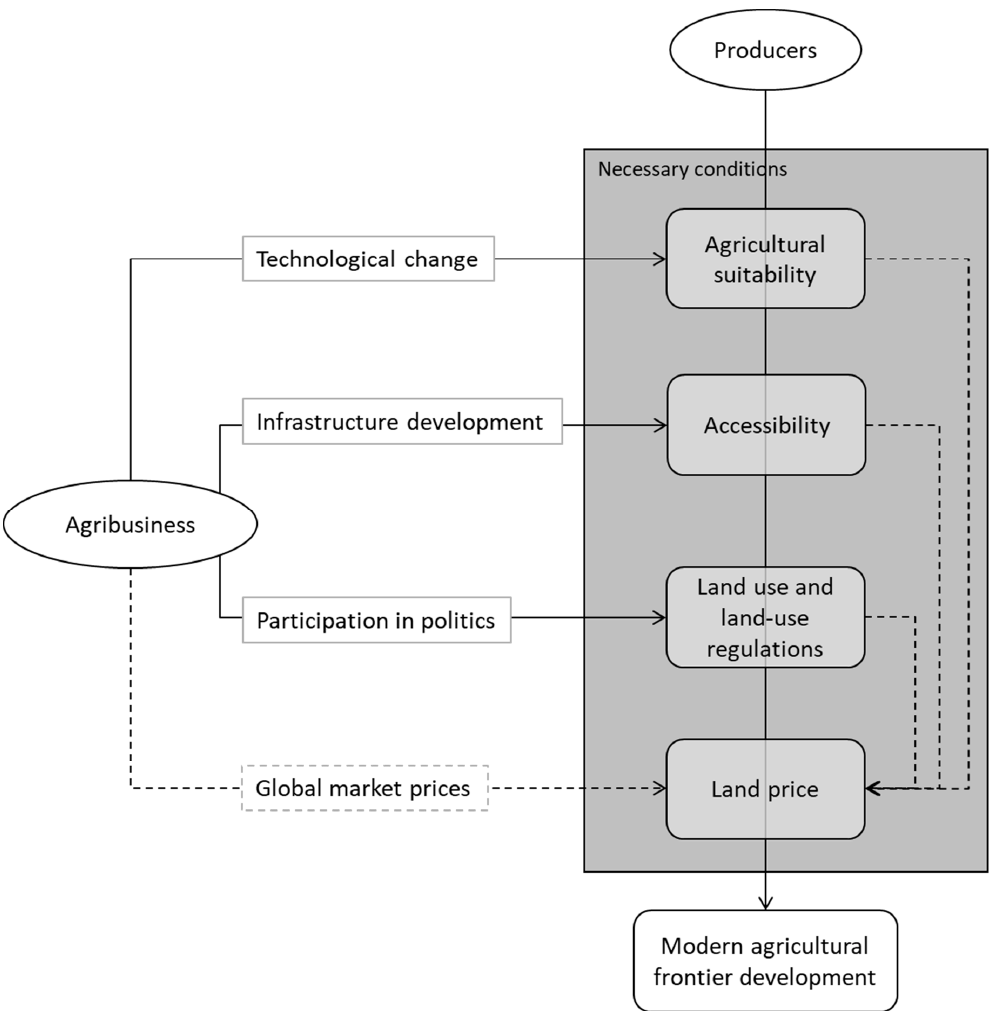
Figure 1. Modern agricultural frontier framework for soy investment. Dashed arrows represent indirect processes.